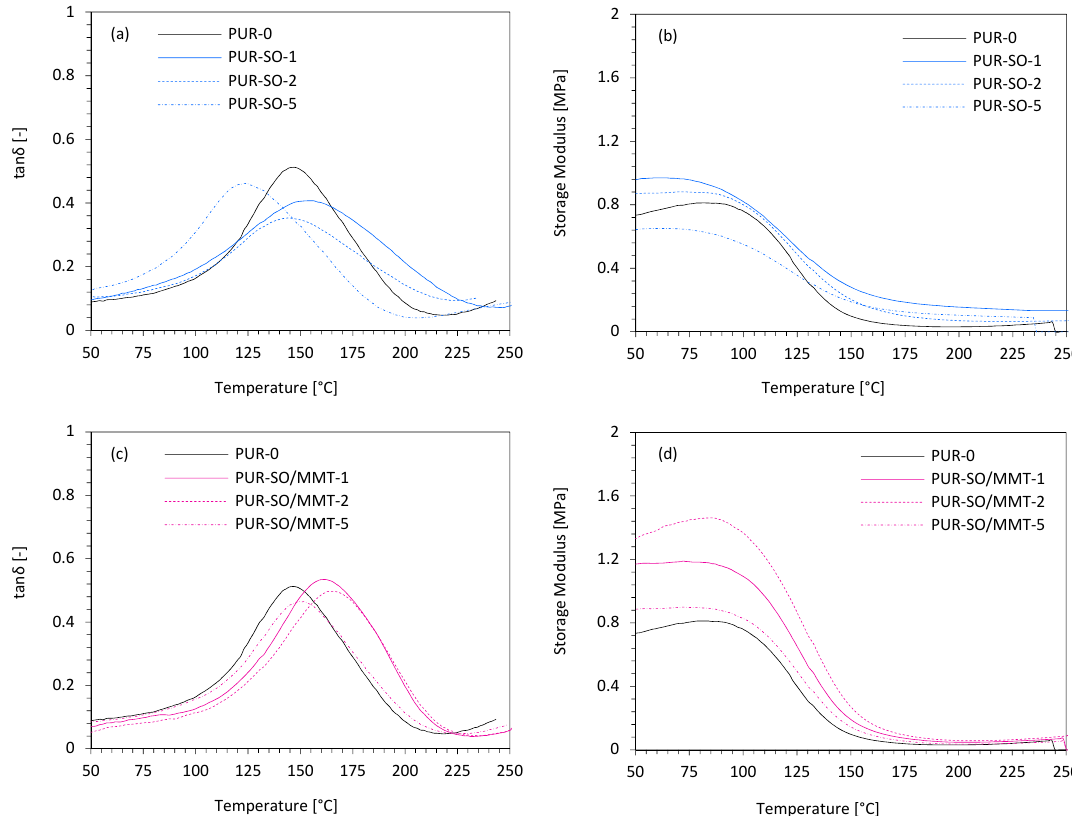
Figure 10. Dynamic mechanical properties of PUR composites—( a , b ) glass transition temperature, and ( c , d ) storage